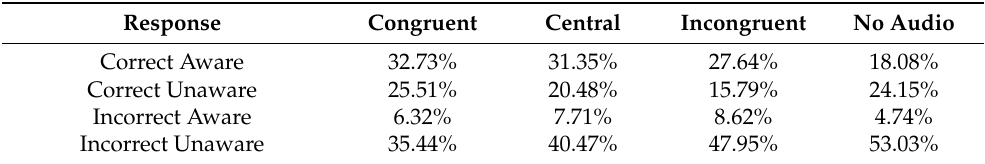
Table 1. Percentage of the types of responses (i.e., correct/incorrect and aware/unaware) per condi- tion for Experiment 2.